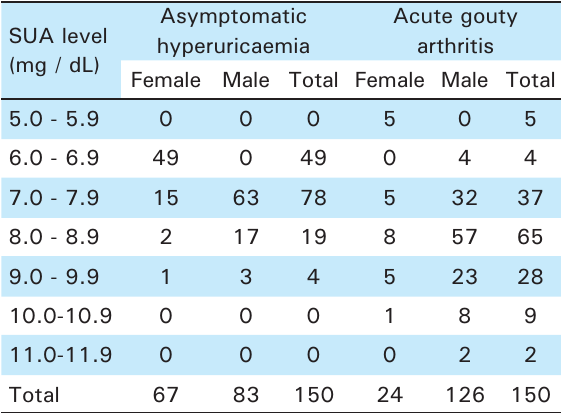
Table 2: Serum uric acid levels in asymptomatic hyperuricaemics and gout cases Asymptomatic SUA level hyperuricaemia